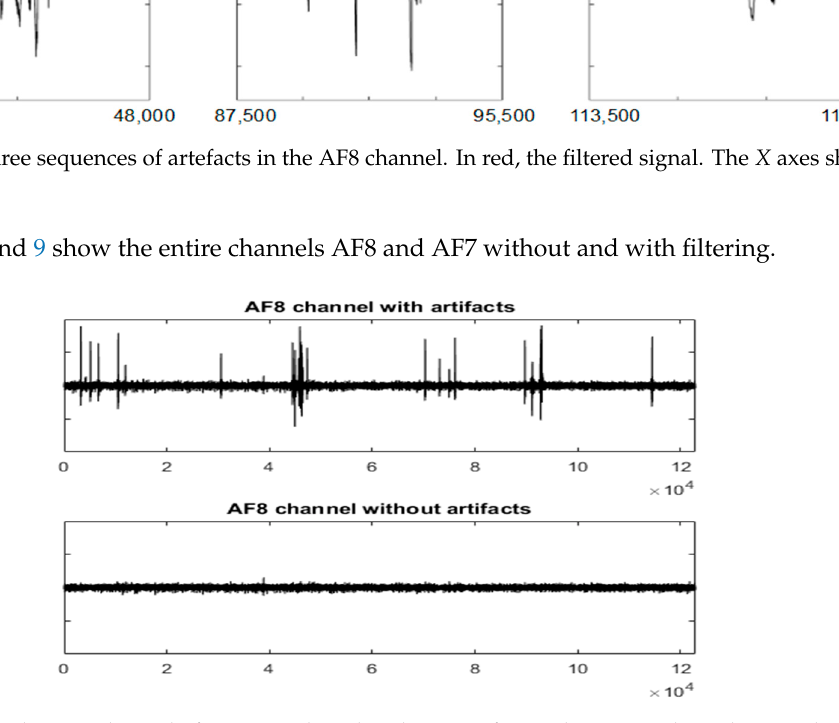
Figure 7. Three sequences of artefacts in the AF8 channel. In red, the filtered signal. The X axes show the samples.